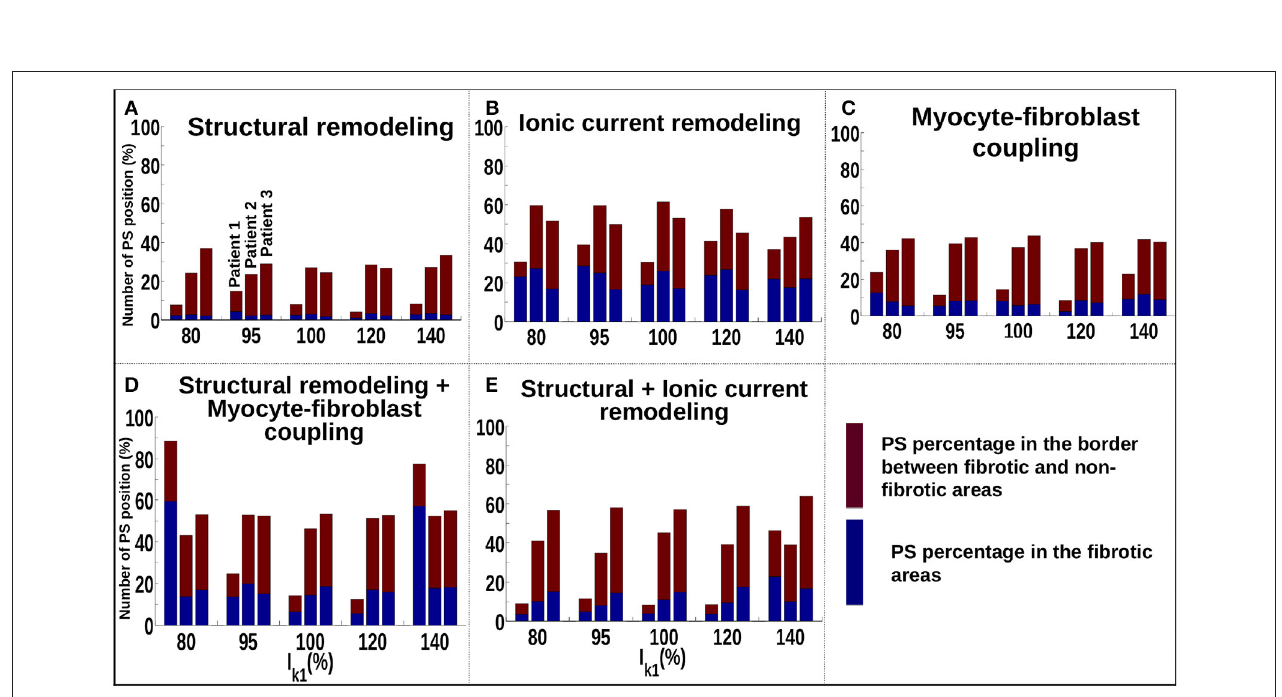
FIGURE 6 | Number of PSs located in the border and in the fibrosis area for patients 1–3 for different fibrosis modeling methodologies, corresponding to: (A) structural remodeling, (B) ionic current remodeling, (C) myocyte-fibroblast coupling, (D) structural remodeling and myocyte-fibroblast coupling, (E) structural and ionic current